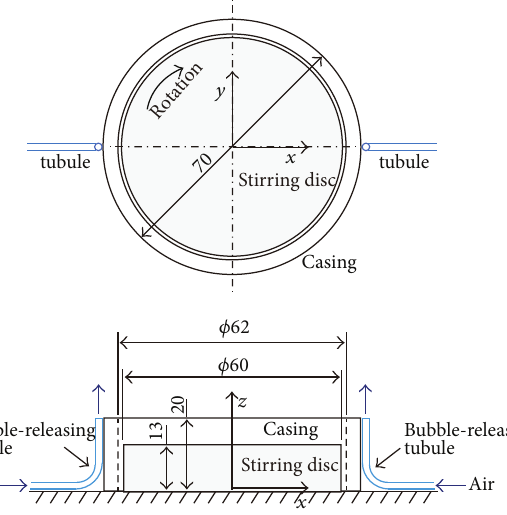
Figure 2: Stirring disc and bubble-releasing